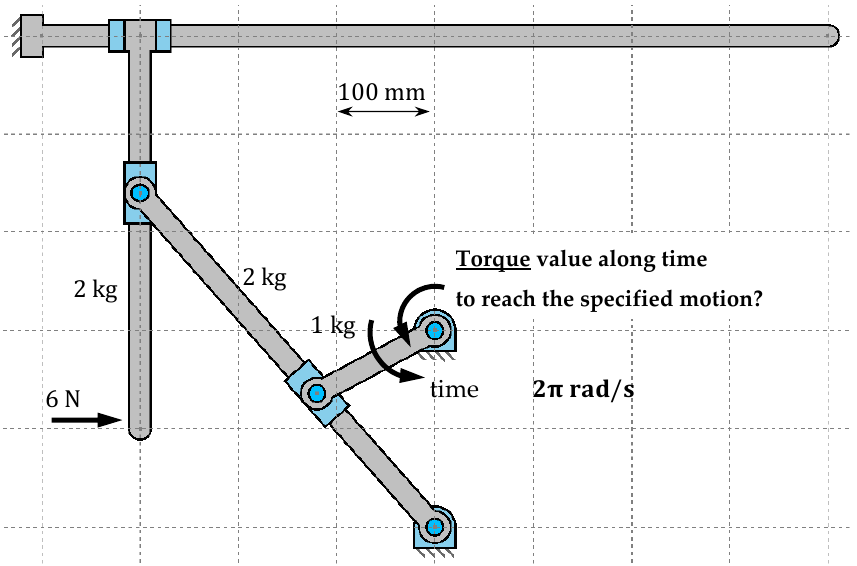
Figure 1. Proposed case study.